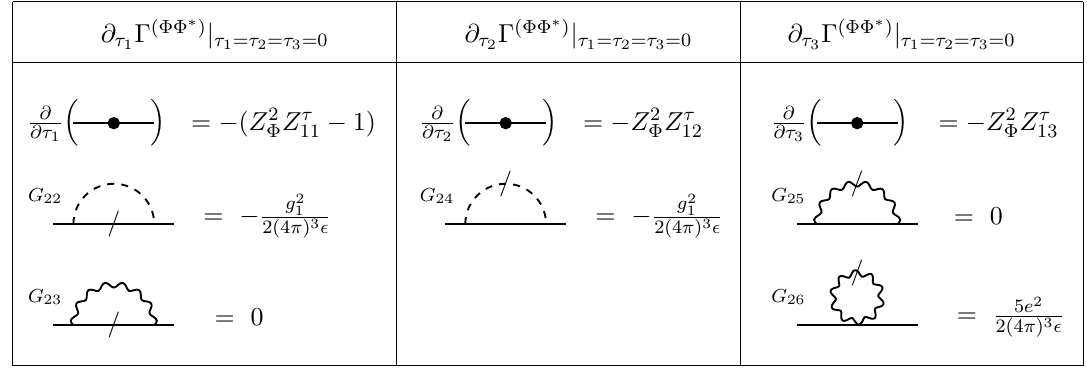
Table 4 . 2-point Green function (cid:0) ((cid:8)(cid:8) (cid:3) ) di(cid:11)erentiated w.r.t.